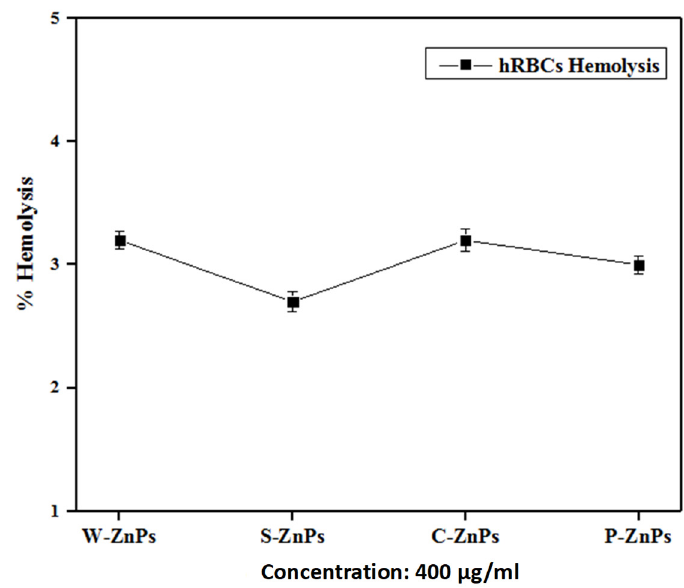
Figure 9. Compatibility of the synthesized ZnO NPs against human red blood cells. The experiments were carried out in triplicates. The values given in figure are mean ± standard deviation of the original data.